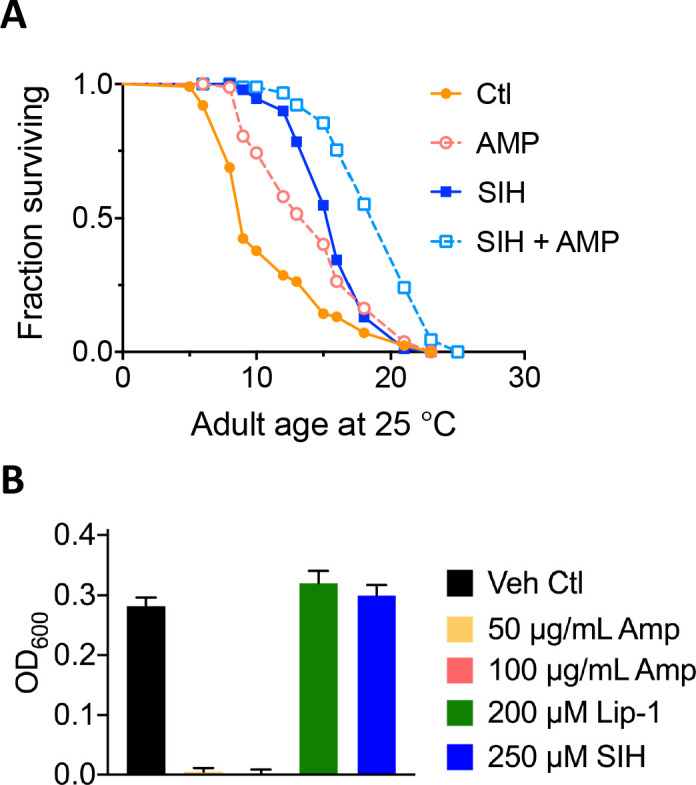
Antibiotic test.To determine whether the increased lifespan seen with SIH treatment could be explained solely by an antibiotic effect of iron reduction, nematodes were treated with ampicillin, with and without SIH co-administration. Even in the presence of ampicillin, SIH increased median lifespan by 6 days, similar to its benefits in the absence of ampicillin (median increase of 7 days), as shown in A. Bacterial Growth Assay: The effects of test compounds on growth of the OP50 E. coli feed was assayed using optical density at 600 nm (OD600). Using standard microtitre plates, replicate wells of 200 µL of sterile Luria broth were inoculated with 2 µL of an overnight OP50 culture in addition to the stated final concentrations of ampicillin (Amp), Lip-1 and SIH. OD600 measures were taken after 12 hr in an EnSpire (PerkinElmer) spectrophotometric plate reader preset to 37°C, with 30 s of 200 rpm orbital shaking every 10 min. Data were averaged across duplicate experiments, each with eight replicate wells per treatment where a baseline of Luria broth without an inoculate was subtracted. Results, shown in B, indicated that ampicillin at either 50 or 100 µg/mL completely suppressed bacterial growth. In contrast, neither Lip-1 nor SIH suppressed bacterial growth. (A) Administration of the antibiotic ampicillin and SIH; AMP = 50 mg / ml ampicillin. Median survival - Log-rank (Mantel-Cox) test: Control (Ctl) = 9 days; AMP = 15 days (p<0.0001); 250 mM SIH = 16 days (p<0.0001); 250 mM SIH + AMP = 21 days (p<0.0001). (B) Effects of compounds on growth of OP50 E. coli. Ampicillin at either 50 or 100 µg/mL completely suppressed bacterial growth. Lip-1 and SIH did not suppress growth.